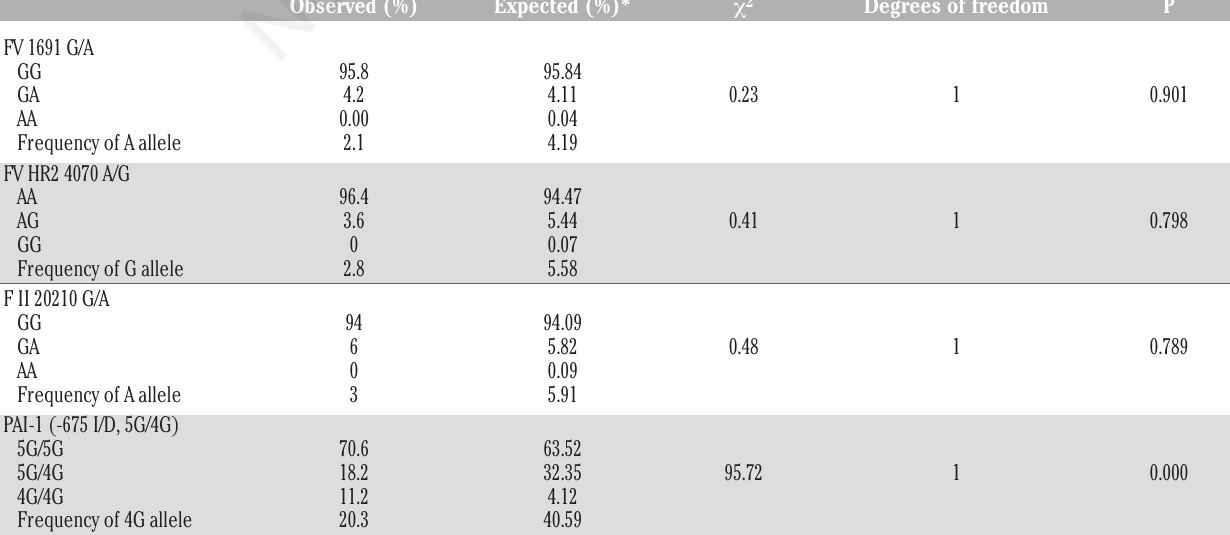
Table 2. Expected and observed frequencies of Factor V (G1691A and A4070G), Prothrombin G20210A and PAI-1 4G/5G polymor- phisms among an Azari population living in northwest of